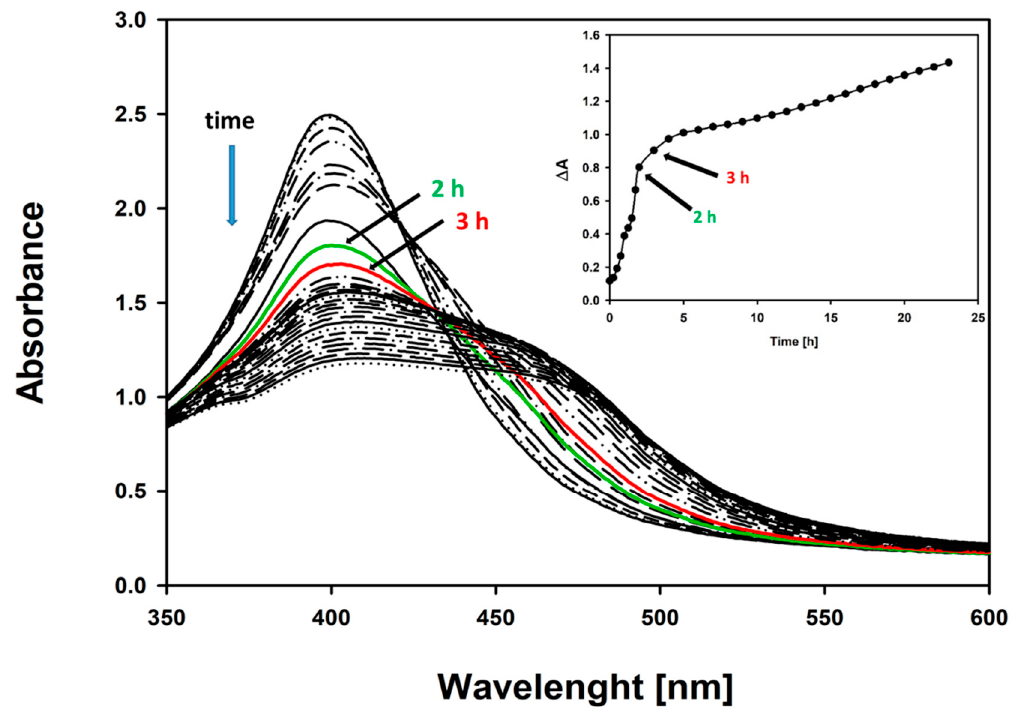
Figure 11. Kinetics of the immunological reaction, with the selected number of FLCs (7 mg/L). Characteristic changes in the absorption spectrum: up to the 2nd h, a decrease in the maximum absorbance at 395 nm occurred; and later, a widening of the spectrum towards longer wavelengths (red-shift) and the formation of a second peak at 470 nm was observed. The inset presents time-dependent absorbance changes at 395 nm. The biggest absorbance changes were observed during the first 2 h of the reaction.